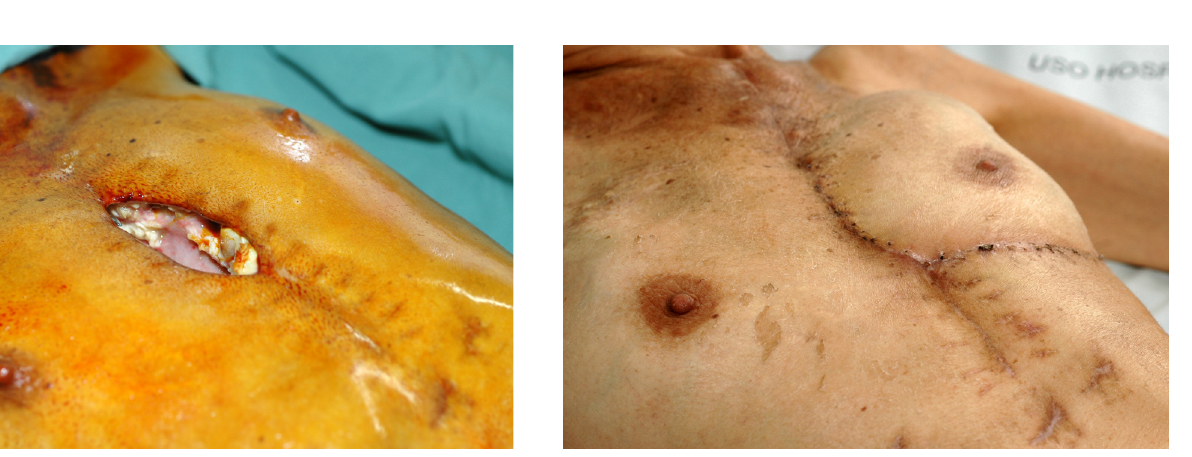
extension.Fig. Fig. 2B - Patient with dehiscence after cardiac transplantation on the 25 th day after the reconstruction.Classified as Type IV, upper partial vertical